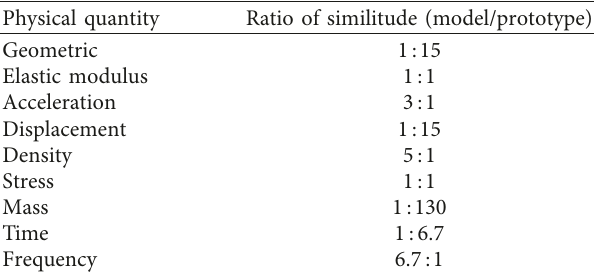
Table 1: Similitude coefficients of the transmission tower model. Physical quantity Ratio of similitude